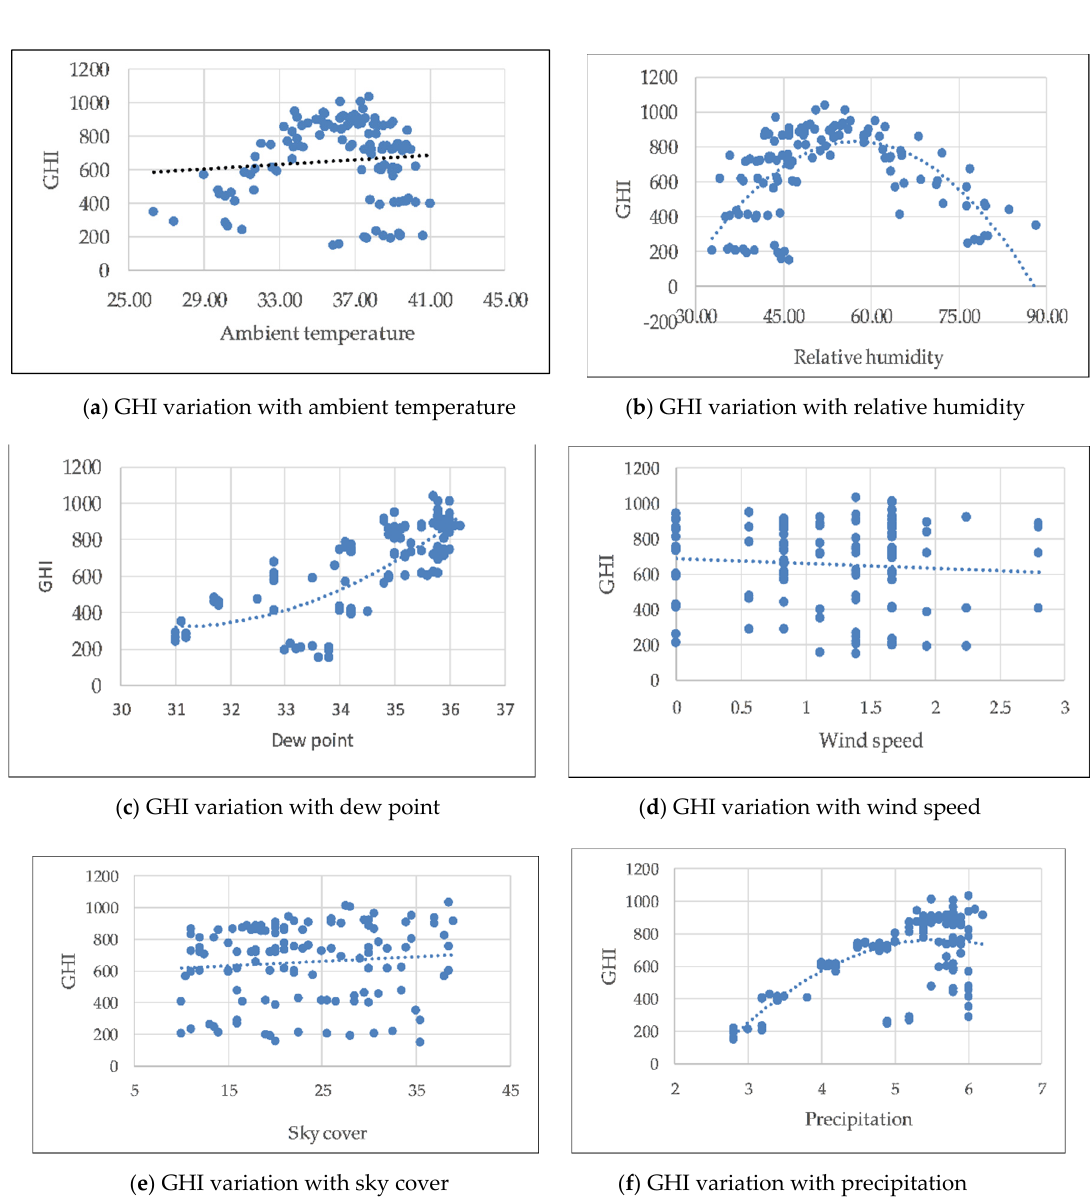
Figure 3. Site weather conditions showing correlation between GHI and other factors including trends. Table 2. Sample data of site weather conditions.